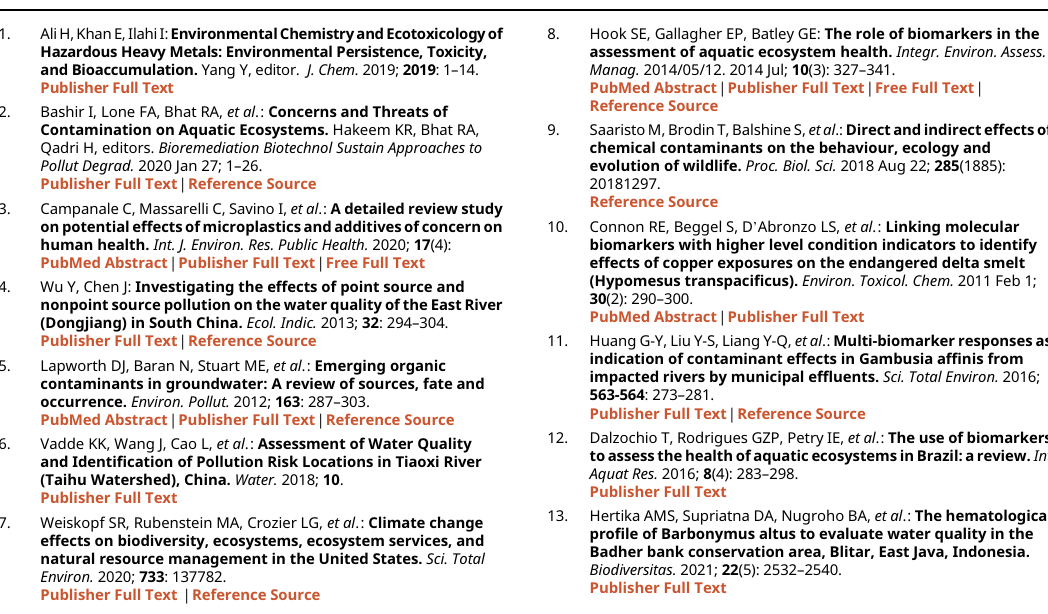
Figshare: Water quality parameters and hematology profile of Gambusia affinis caught at Brantas River watershed, Indonesia. https://doi.org/10.6084/m9.figshare.16895227.v1. 90 Data are available under the terms of the Creative Commons Zero “ No rights reserved ” data waiver (CC0 1.0 Public domain